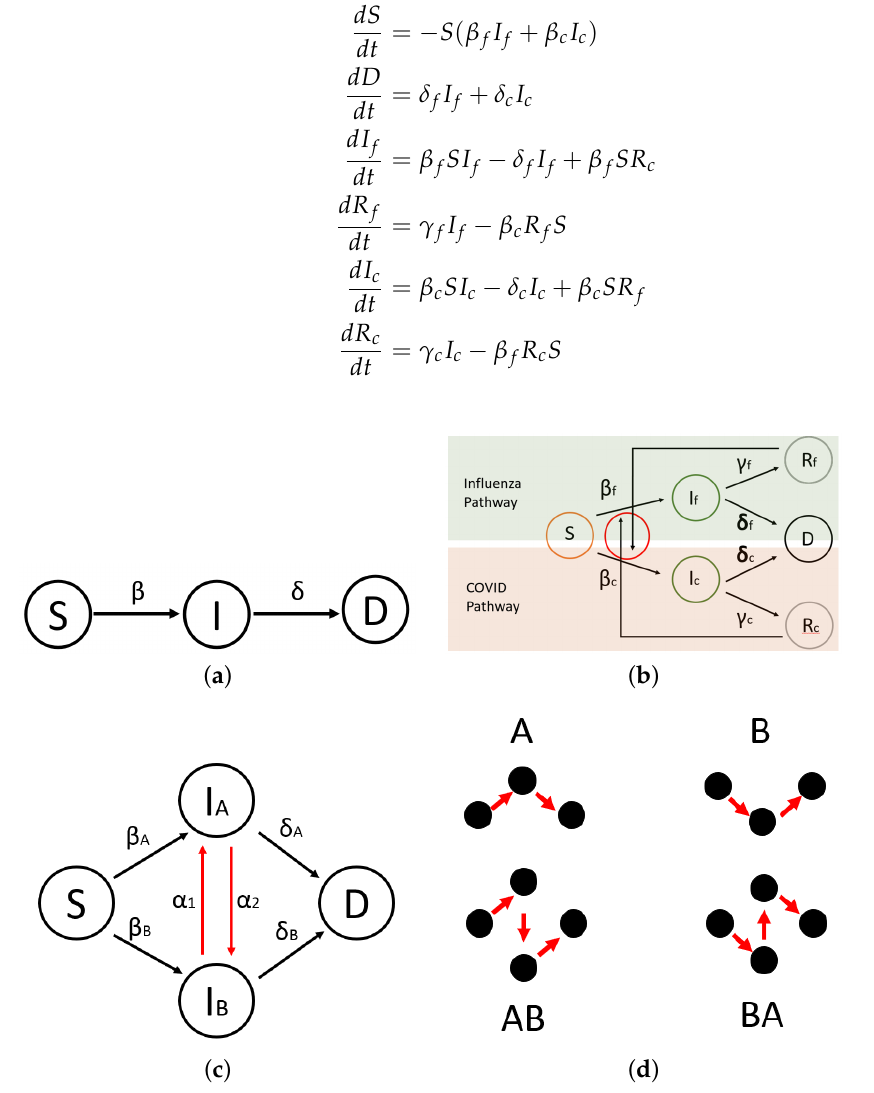
Figure 1. ( a ) Schematic of the simple compartmental model to which data are fitted. ( b ) Schematic of the compartments in the twindemic spread model. This model allows for the interplay of competing pathways to infection, thus emulating the possibility of a SARS-CoV-2 epidemic occurring in the presence of another viral pathogen. ( c ) Exploratory setup of multi-strain modeling containing a bridge between mutating pathogens. ( d ) Schematic of different pathways to infection in the multi- strain